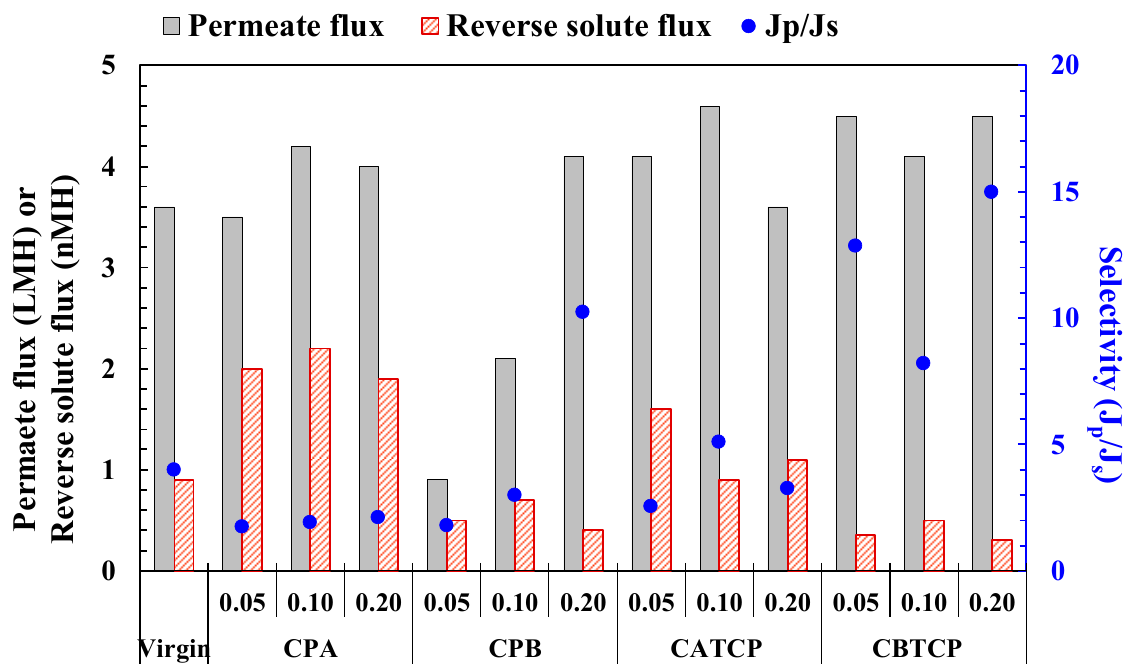
Figure 4. FO performance of the TFC and TFN membranes using hybrid materials with different dosages (%). The experimental conditions are presented in Table 1.